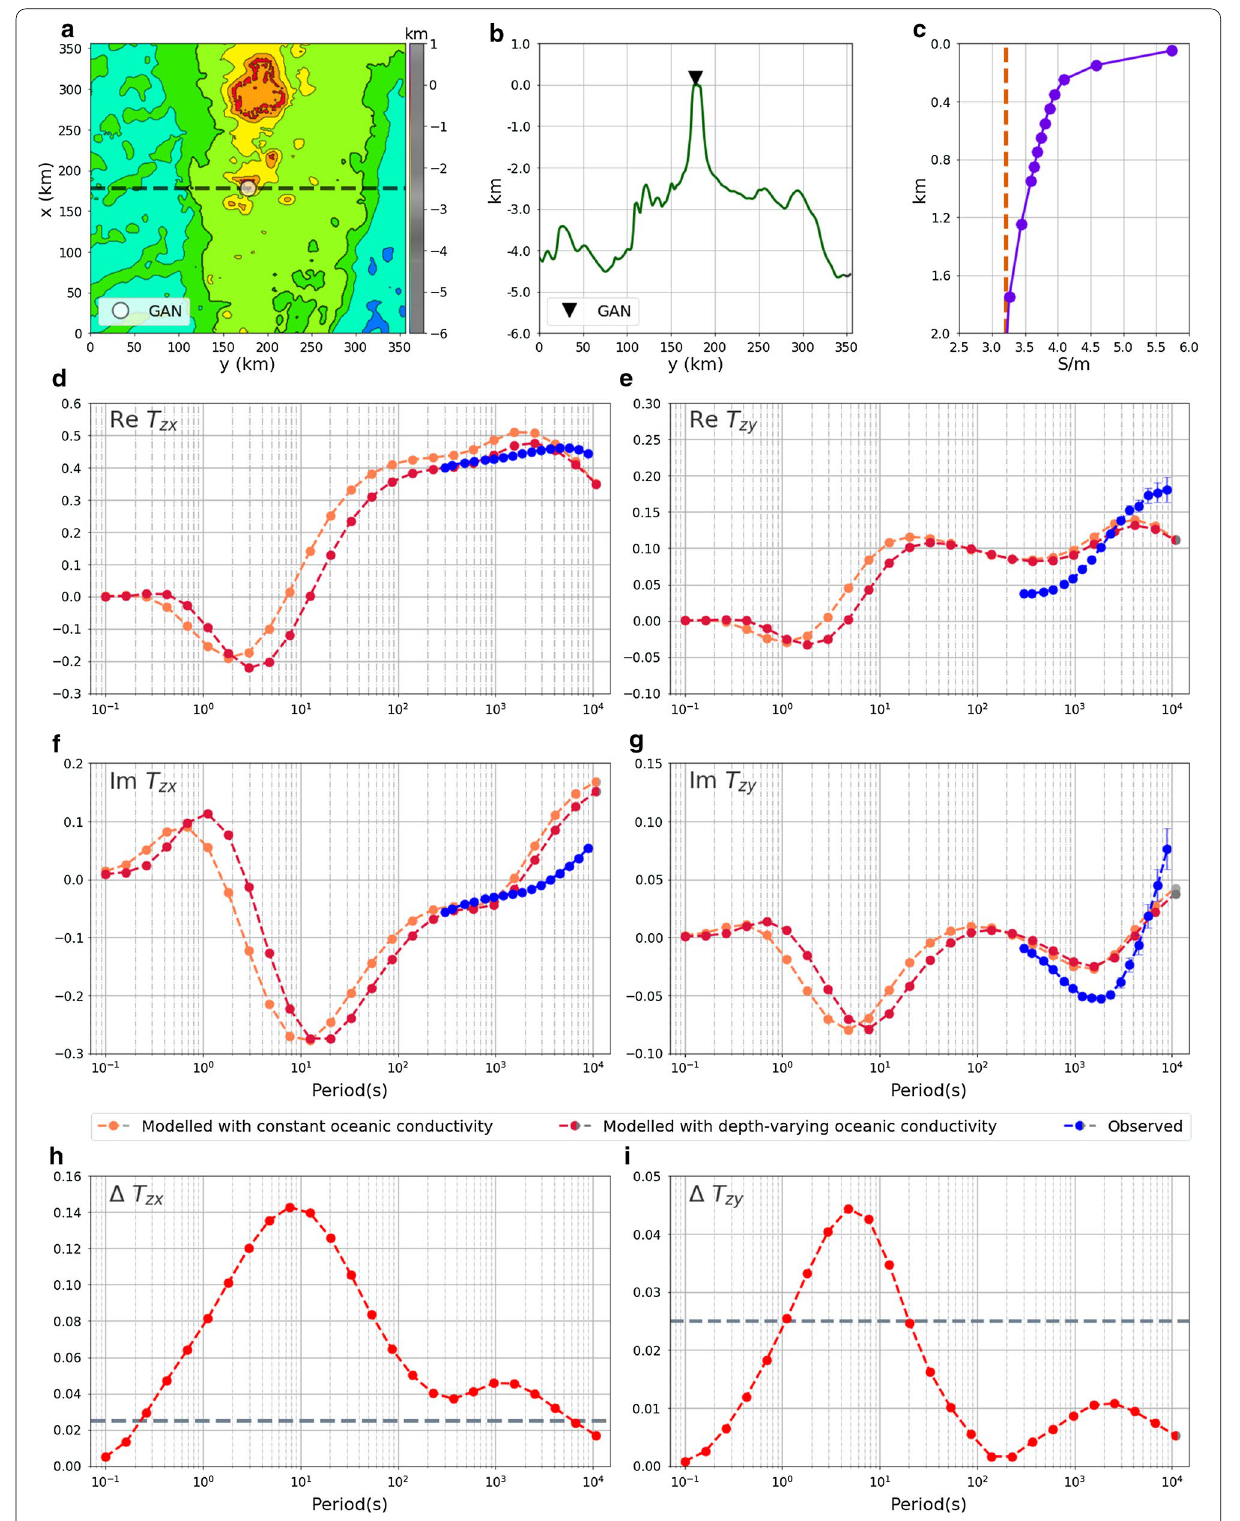
Fig. 8 Same as Fig. 5, but for Gan observatory